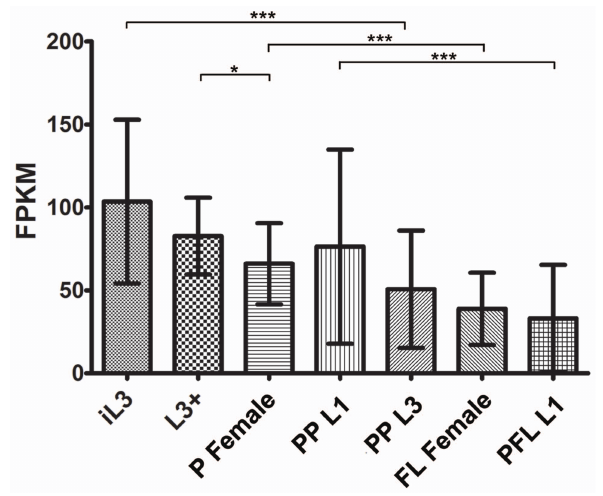
Figure 4. Transcriptional profiles of Ss-riok-1 . Transcript abun- dances were determined for the C-terminal coding region of Ss-riok-1 , in seven developmental stages: parasitic females (P Female), post-parasitic first-stage larvae (PP L1), post-parasitic third-stage larvae (PP L3), free- living females (FL Female), post free-living first-stage larvae (PFL L1), infectious third-stage larvae (iL3), and in vivo activated third-stage larvae (L3 + ). Transcript abundances were calculated as fragments per kilobase of coding exon per million mapped reads (FPKM). Bracket with 1 star represent the significant difference ( p , 0.05 ), brackets with 3 stars represent the significant difference ( p , 0.01) in transcript abundances between the two selected stages. Error bars represent 95% confidential intervals.